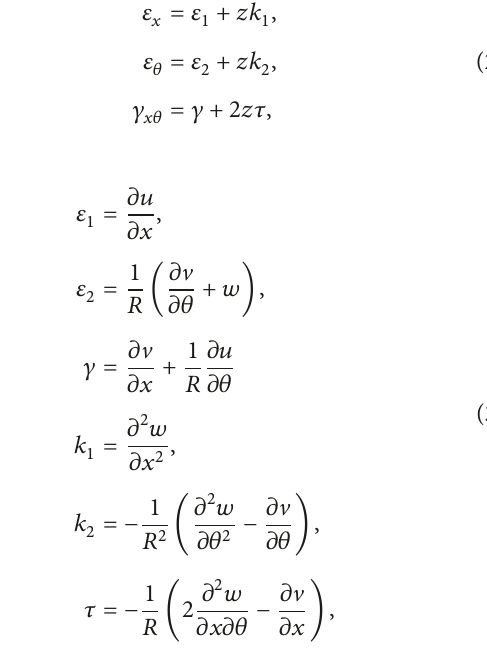
The strain-displacement relations of TCS with hard coat- ing can be expressed